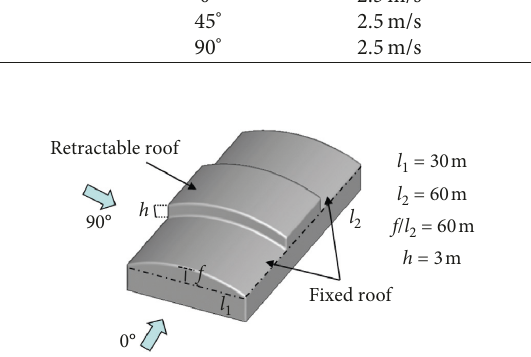
Figure 10: Horizontally retractable roof model.